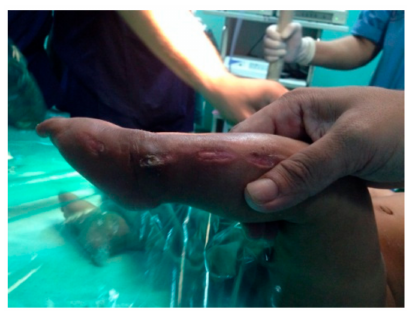
Figure 10. Skin abrasions.